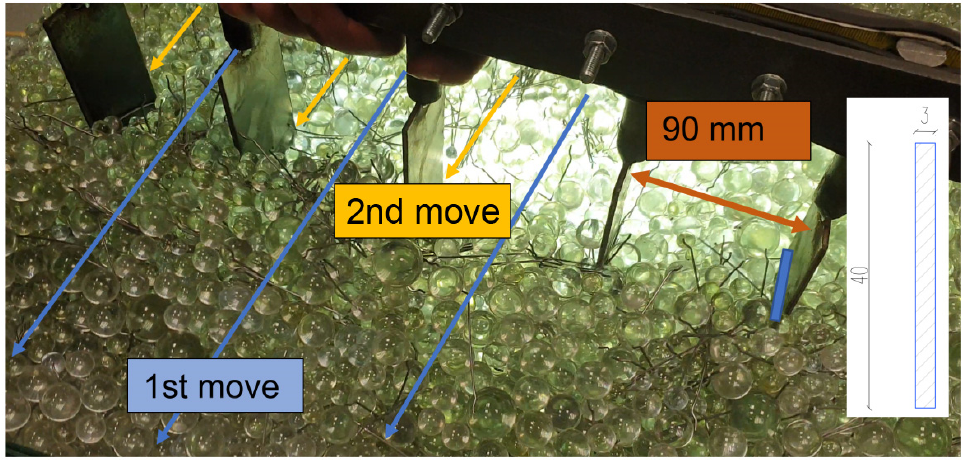
Figure 13. Evaluation of the resulting fibre direction.